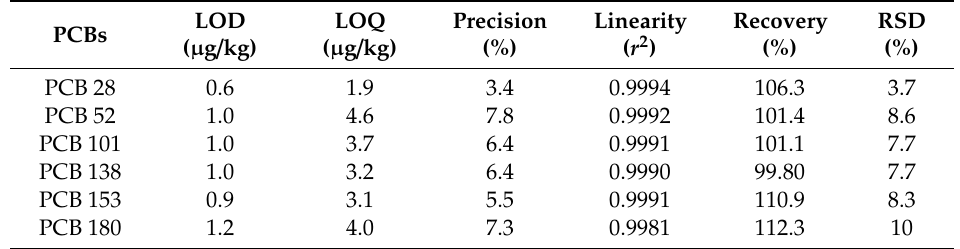
Table 4. The average values of LOD, LOQ, precision, linearity, recovery and RSD in blank smoked meat samples, spiked with 50 µ g / kg ( n =